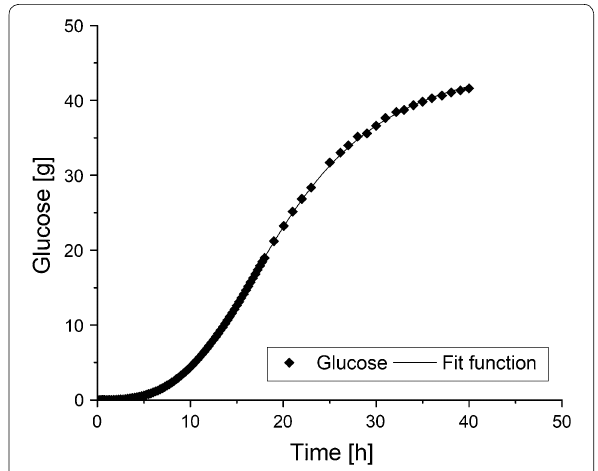
Fig. 3 An exemplary fit of the glucose feed of a fed-batch fermentation of S. cerevisiae in a KLF2000 fermenter (working volume 1.8 L). Glucose sum curve and mathematical fit with Origin ® Pro